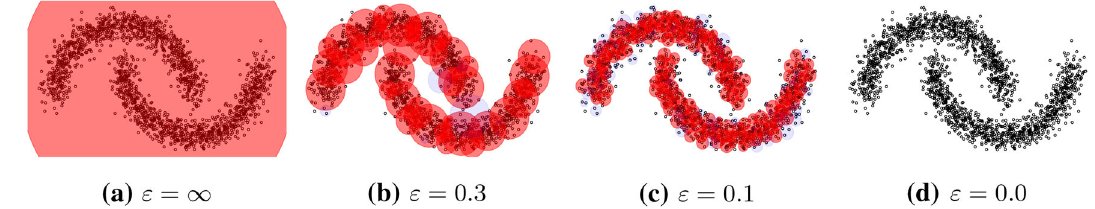
Fig.1 Two moons dataset clustered with different instances of DenStream. Potential micro-clusters are drawn in red, outlier micro-clusters in blue